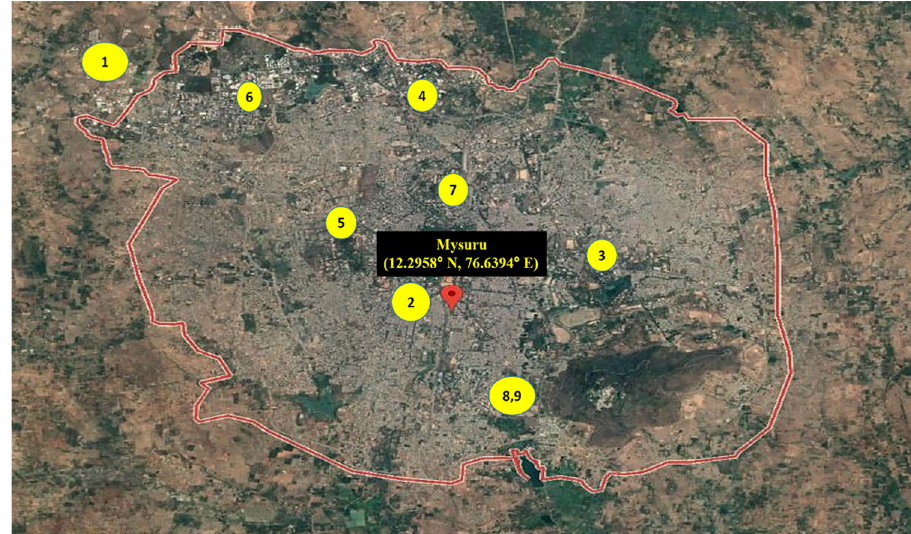
Fig. 2 Sampling sites